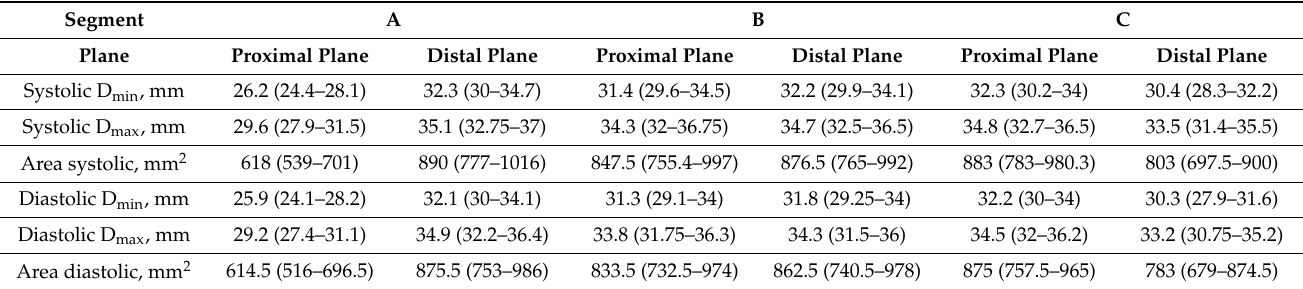
Table 2. Segmental area and systolic/diastolic diameter values a .